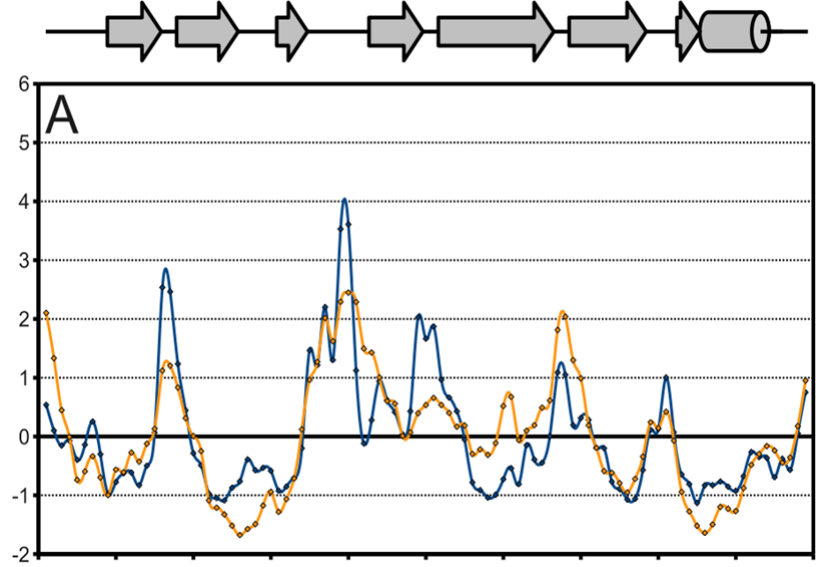
Table 2. Secondary structure elements are